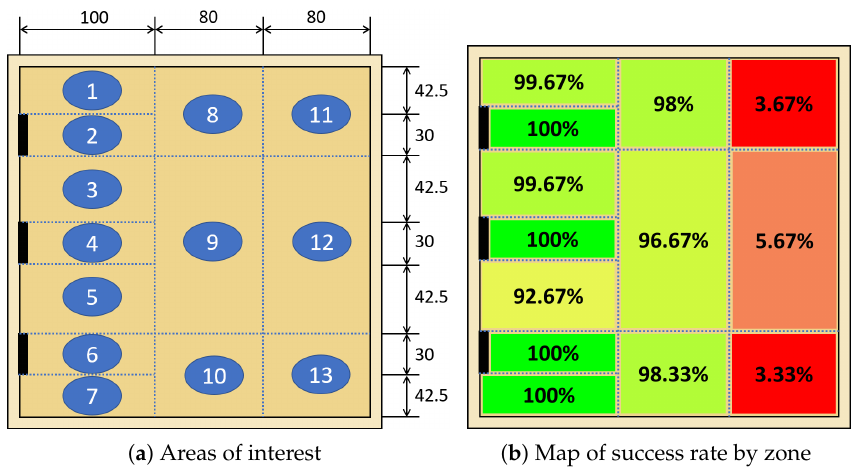
Figure 11. Estimation of success rate by compartment areas (Green colour denotes high detection areas and red colour the lowest detection zones).